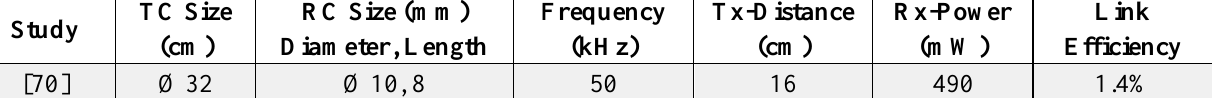
Table 5. Overview of Helmholtz coil-based system